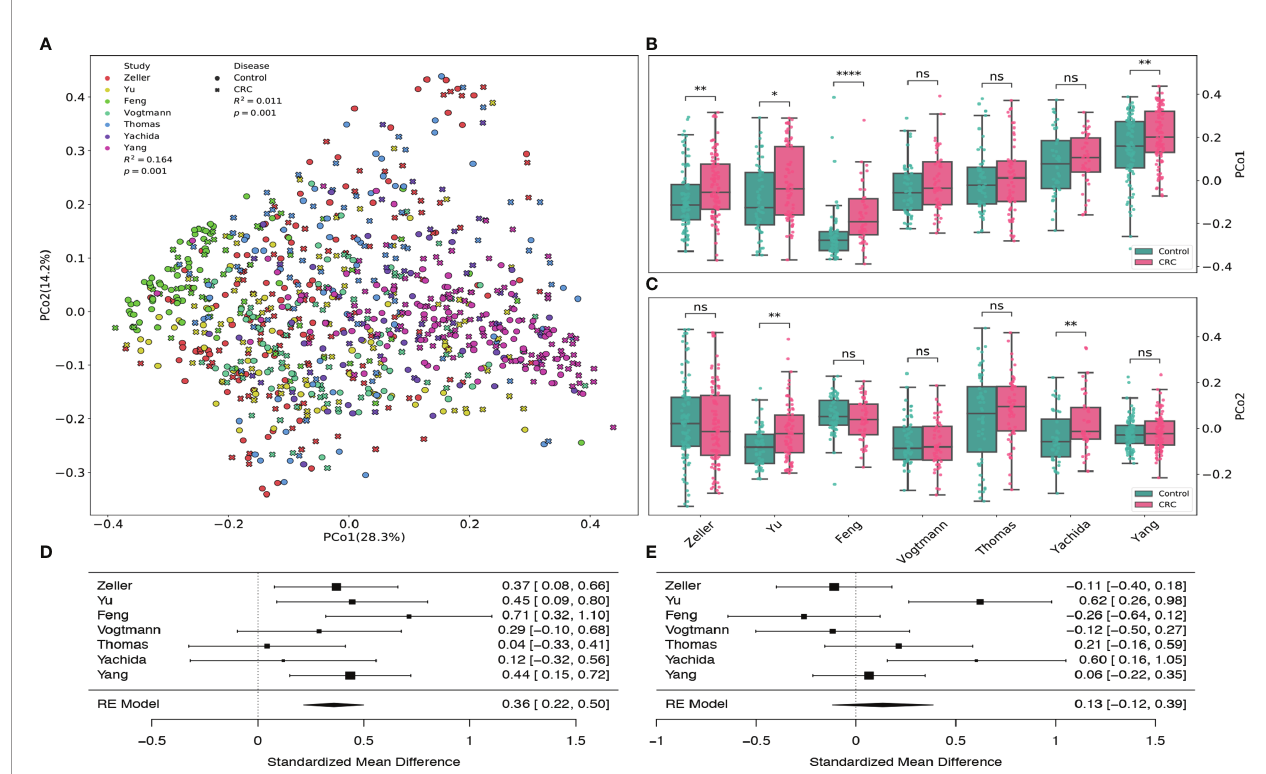
FIGURE 2 | Principal coordinates analysis of all samples based on Bray – Curtis distance. (A) PCoA plot of gut samples of CRC subjects and healthy controls in each dataset. R 2 values and p-values were calculated by PERMANOVA. (B) Boxplots of the fi rst principal coordinates (PCo1) in each dataset. (C) Boxplots of the second principal coordinates (PCo2) in each dataset. BH adjusted p-values were calculated using the two-tailed Wilcoxon rank-sum test. ns:p> 0.05, *p< 0.05, **p< 0.01, ***p< 0.001, ****p< 0.0001. (D) Forest plot showing effect sizes from a meta-analysis on PCo1. (E) Forest plot showing effect sizes from a meta-analysis on PCo2. RE Model: Random effect